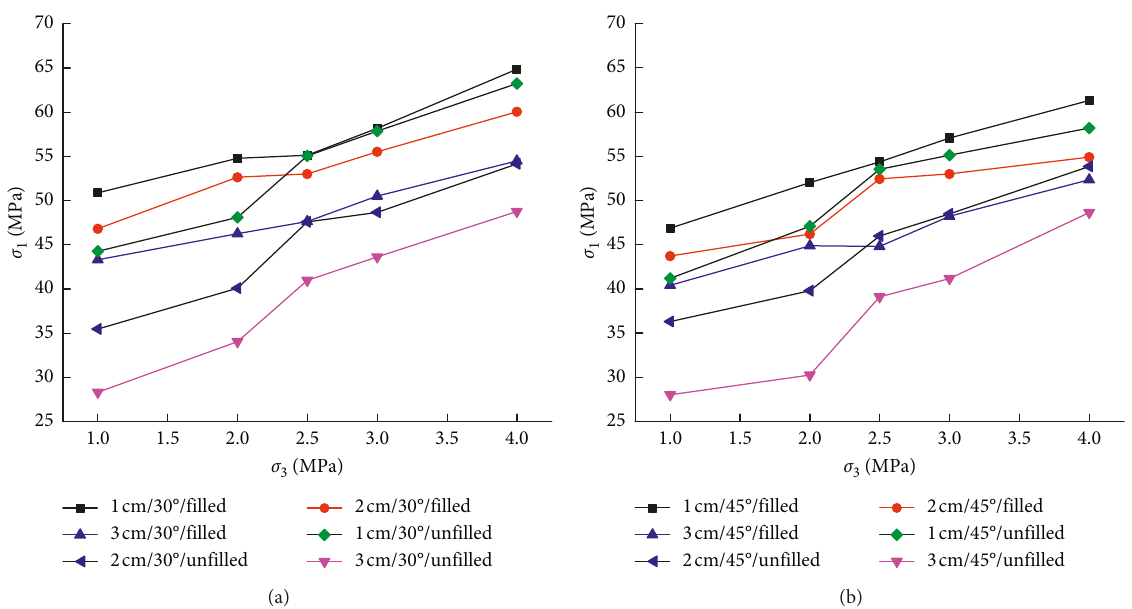
Figure 11: Variation in the peak strength of the specimens containing a grout-infilled flaw and unfilled flaw with the confining pressure when the flaw inclination angle is (a) 30 ° and (b) 45 °